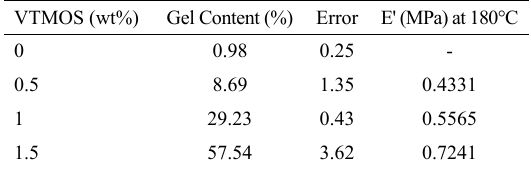
Table 3. Gel content and Storage Modulus (E’) of HMWPE and VTMOS crosslinked HWMPE. VTMOS (wt%)